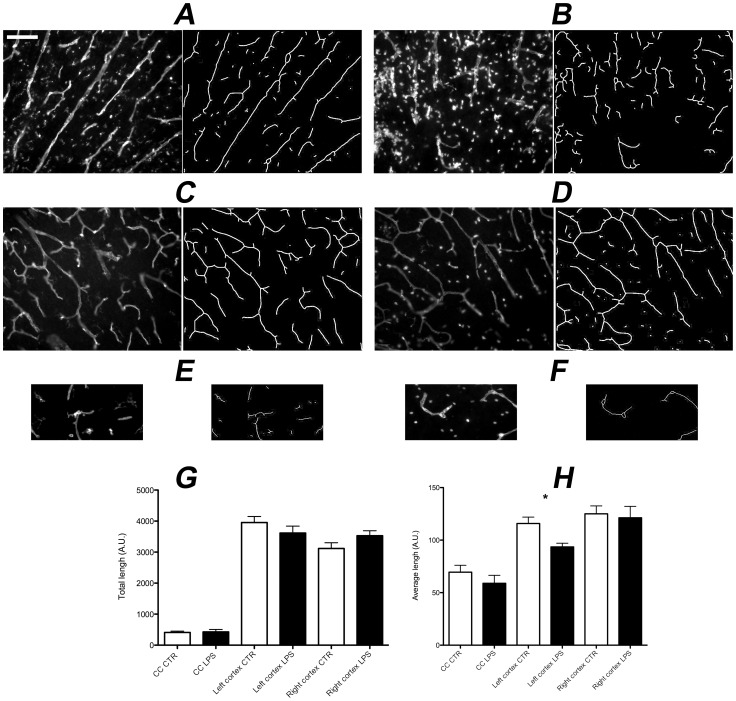
TRITC-conjugated lectin staining of brain sections 24h after LPS or saline injection with the associated microvascular skeleton extracted with Angio Tool.(A) left cortex; sham, (B) left cortex; LPS, (C) right cortex; sham, (D) right cortex; LPS, (E) corpus callosum; sham, (F) corpus callosum; LPS. The average microvessel length in the left cortex of brains injected with LPS (B) is reduced with vessels appearing fragmented compared to the brain injected with saline (A). Bar graphs of total microvessel length (G) and average microvessel length (H) in rat brain sections over the cortex and corpus callosum using the skeleton technique with AngioTool. Note the significant decrease in average microvessel length on the left cortex in brains injected with LPS (* p = 0.0093). Scale bar  = 100 μm.